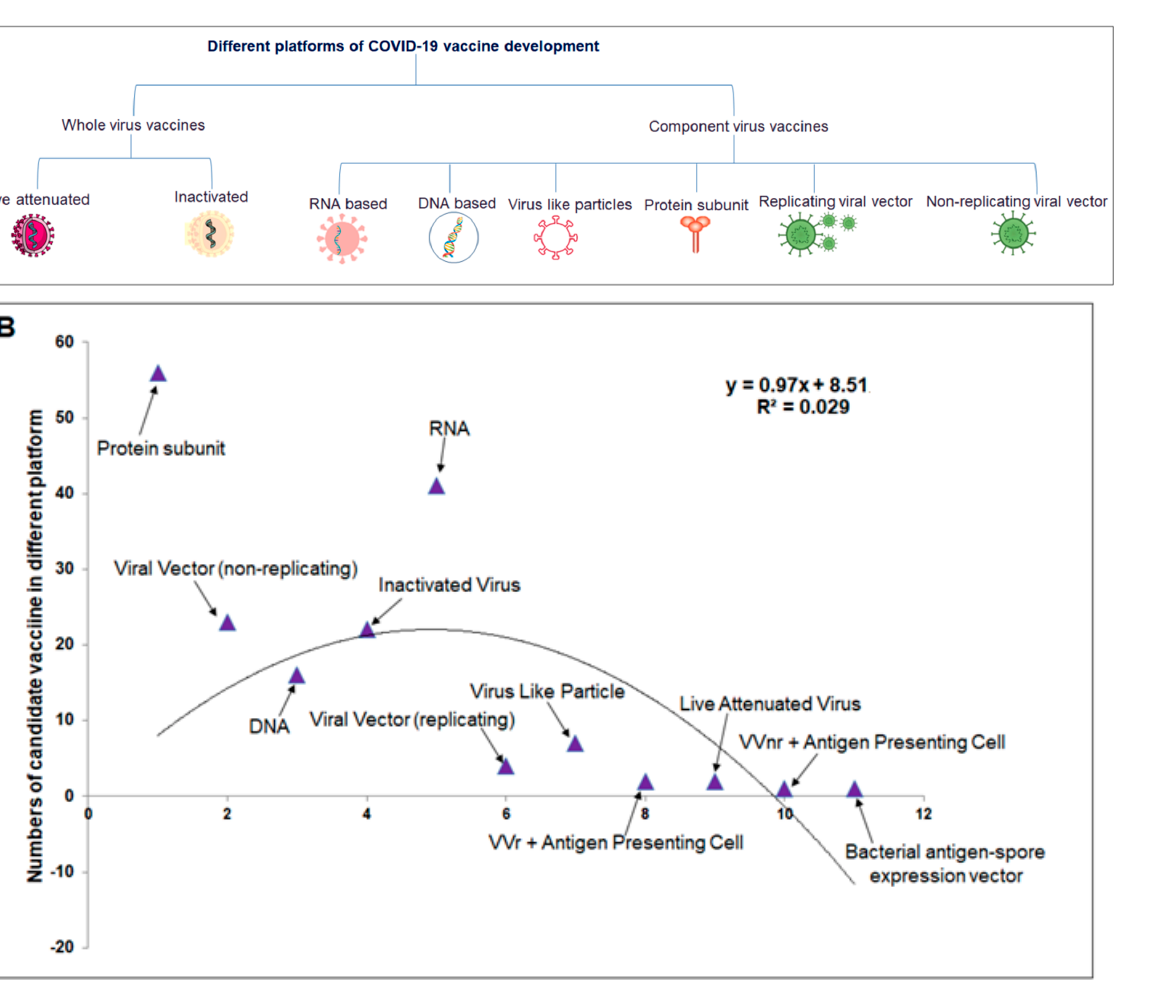
Figure 3. Different vaccine platforms and different clinical trials of vaccines. ( A ) A schematic chart that describes different vaccine platforms. ( B ) A statistical model was developed using the number of clinical trials. ( C ) Percentages of vaccine platforms described through a pie chart.